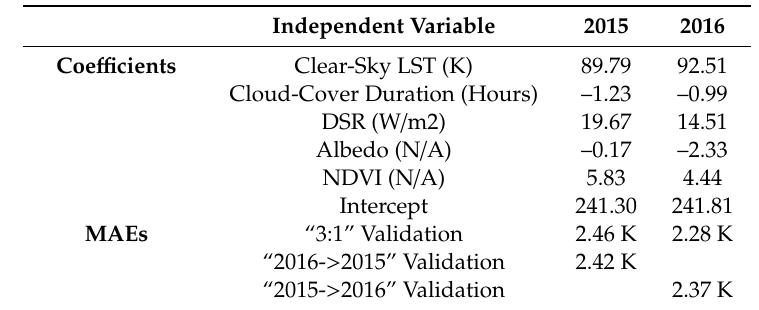
Table 4. Multiple linear regression coe ffi cients and MAEs in 2015 and 2016 when only selecting the points with clear-sky LST values greater than the SURFRAD